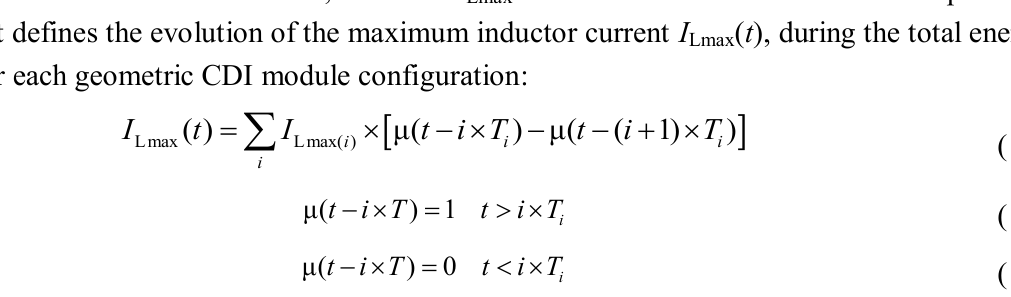
Table 2. Desalination system efficiency for several geometrical configurations with I